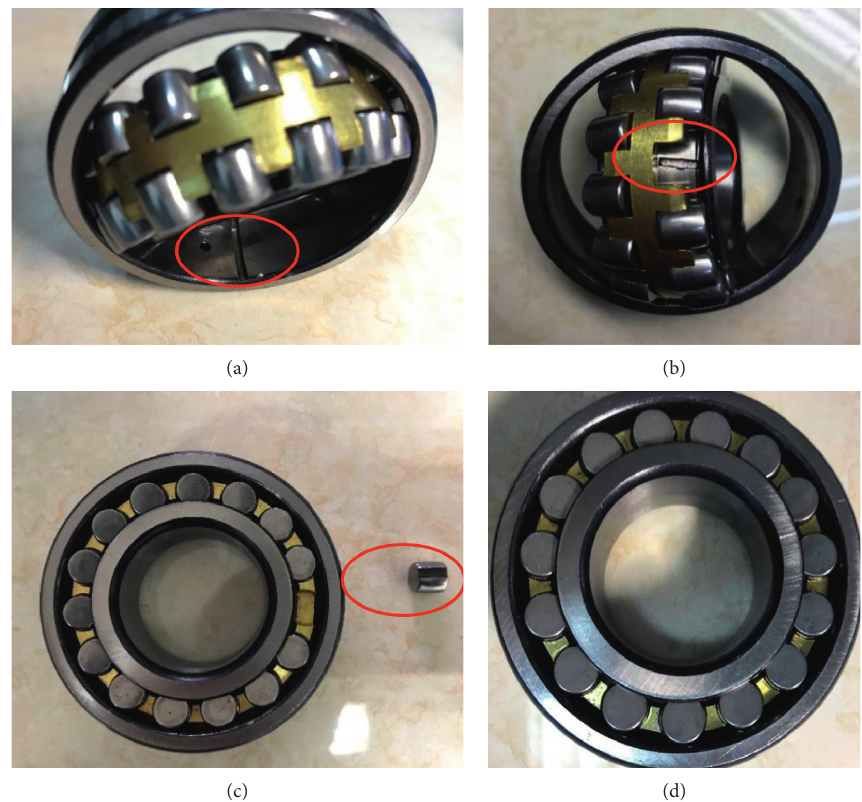
Figure 12: The object diagram of the roller bearing: (a) outer ring fault; (b) inner ring fault; (c) rolling element fault; (d)